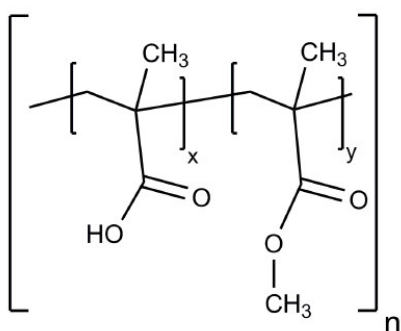
Figure 1. Chemical structure of Eudragit ® L100; x ≈ y ≈ 1 (ratio of methacrylic acid and methyl methacrylate units); n = degree of polymerization